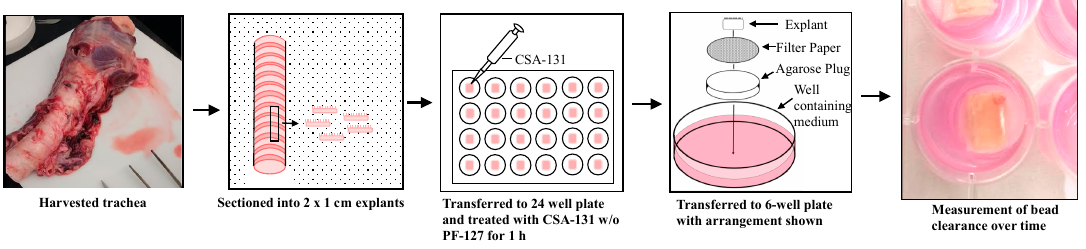
Figure 5. Description of methods used in harvesting and testing porcine trachea explants.